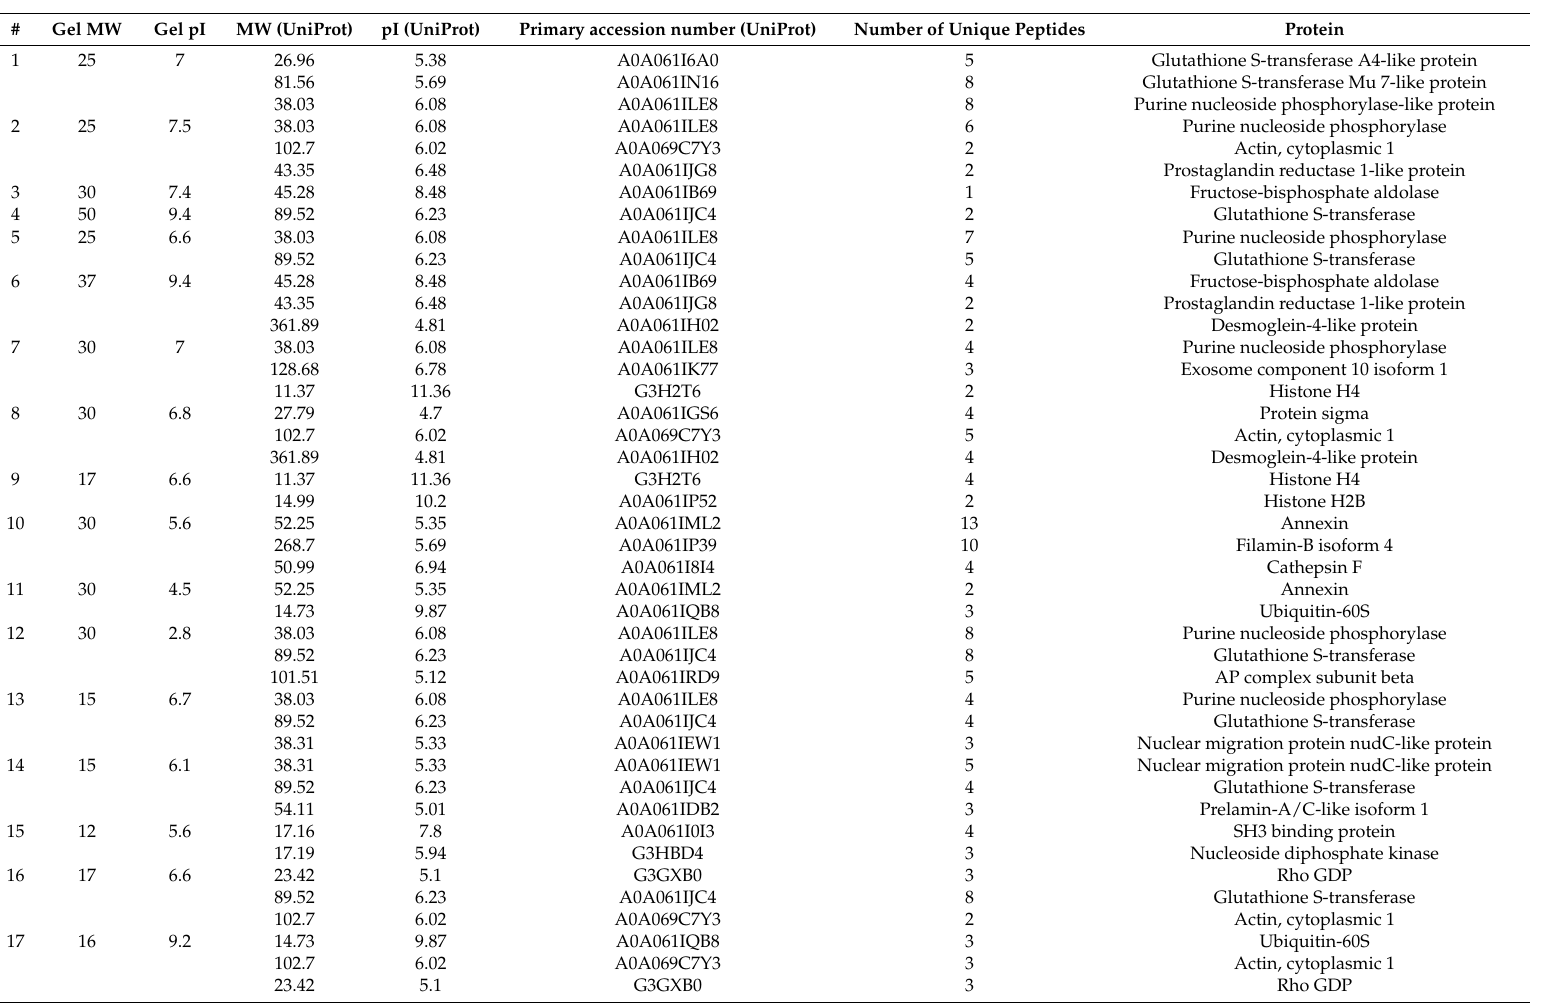
Table A2. Peptides and their corresponding proteins identified via LC-MS/MS in spots of 2D gel of the diafiltrated broth. Molecular weight (MW) and isoelectric point (pI) of the unmodified full length protein according to